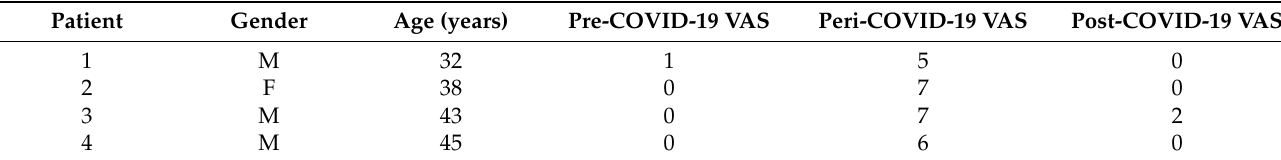
F—female, M—male, VAS—visual analogue F — female, M — male, VAS — visual analogue scale.